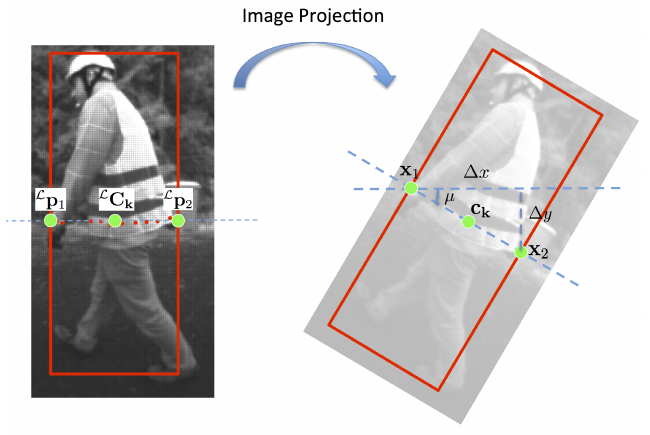
Figure 16. Computation of the ROI angle on the